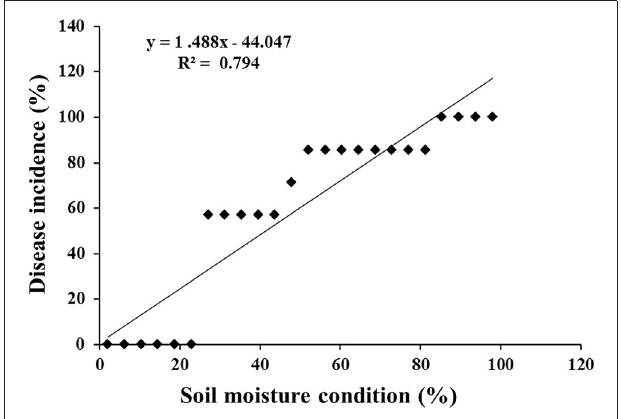
FIGURE 1 | Scatter plot with corresponding regression line and regression equation for the relationship between the dependent variable disease incidence (%) and independent variable soil moisture condition (%).